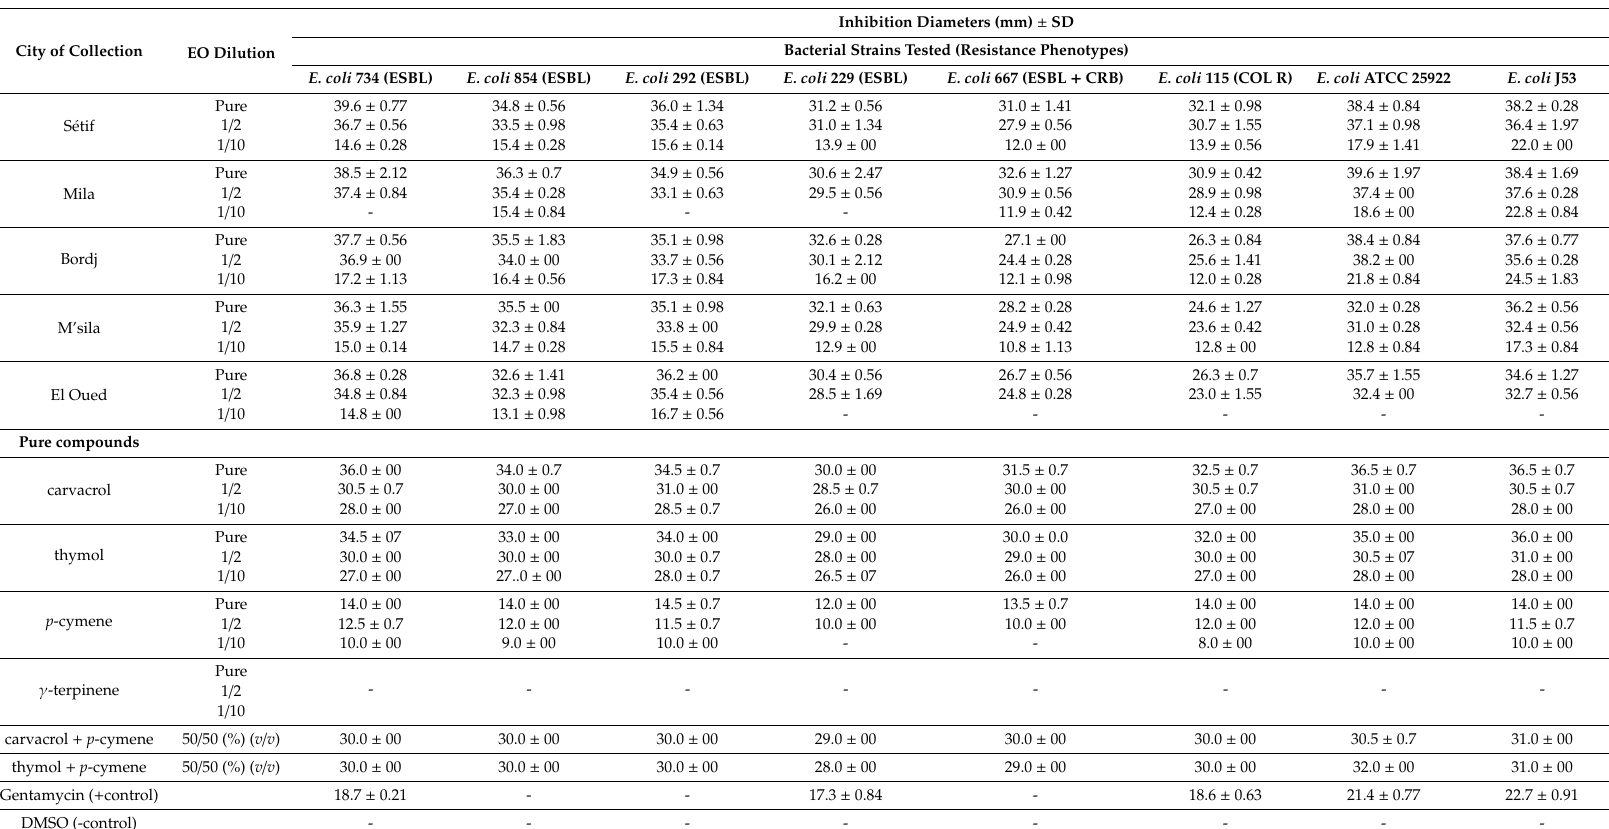
Table 2. Antibacterial activity of the EOs from five populations of the endemic Algerian O. glandulosum expressed as diameter inhibition zones. City of